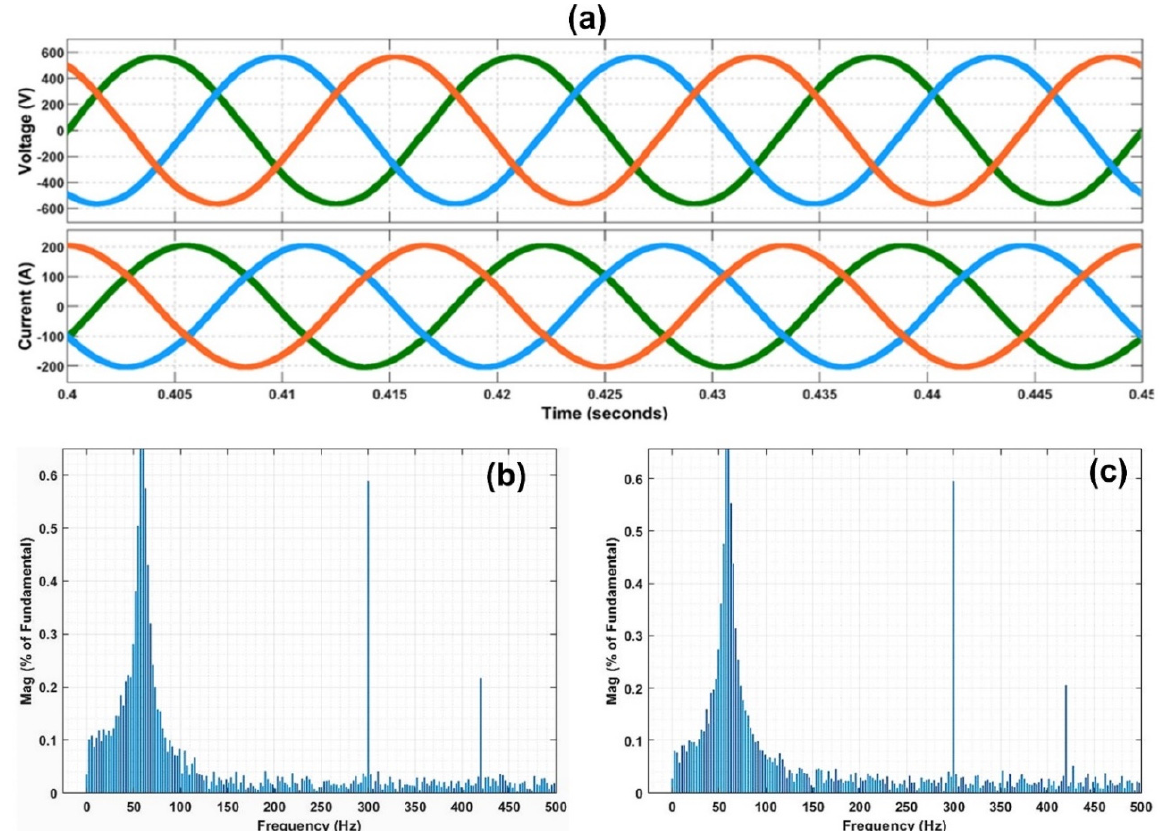
Figure 16. ( a ) Waveform of instantaneous voltage and current of microgrid computed at a load power of 100 kW, ( b ) and ( c ) THD analysis of load voltage and current, respectively.